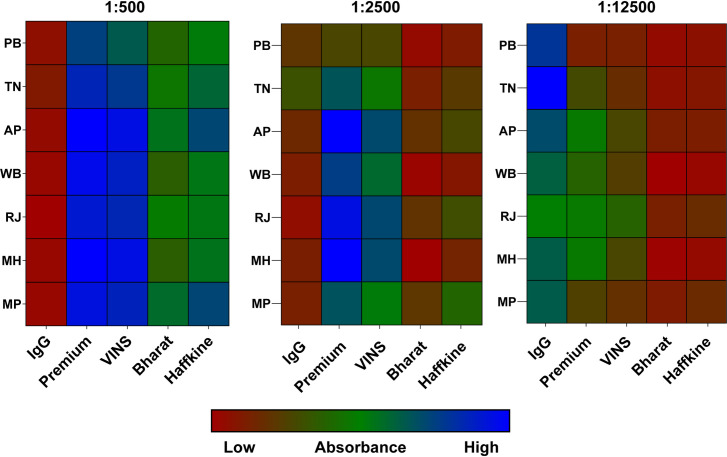
The immunological cross-reactivity of commercial Indian antivenoms against Naja venoms.Quantification of antibody binding of various commercial Indian antivenoms and naive horse IgG to the various snake venoms, determined by ELISA. Absorbance was measured at 405 nm for various dilutions (1:500, 1:2500 and 1:12500) of the antivenom, and the extent of binding shown as a colour gradient from red (low binding) to blue (high binding).